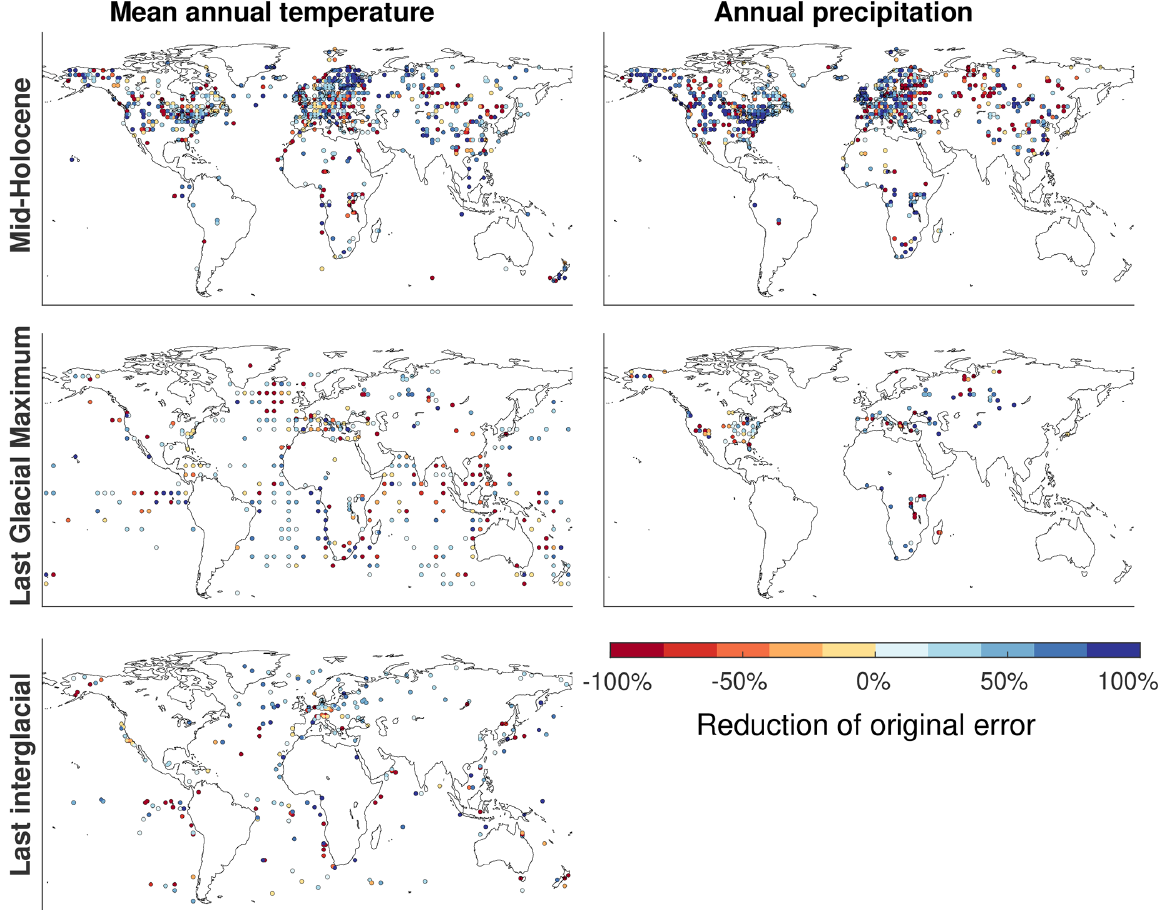
Figure 3. Reduction of the original model bias by the delta method for terrestrial and marine mean annual temperatures and terrestrial annual precipitation. The lower end of the colour scale was capped at − 100% (i.e. a doubling of the original